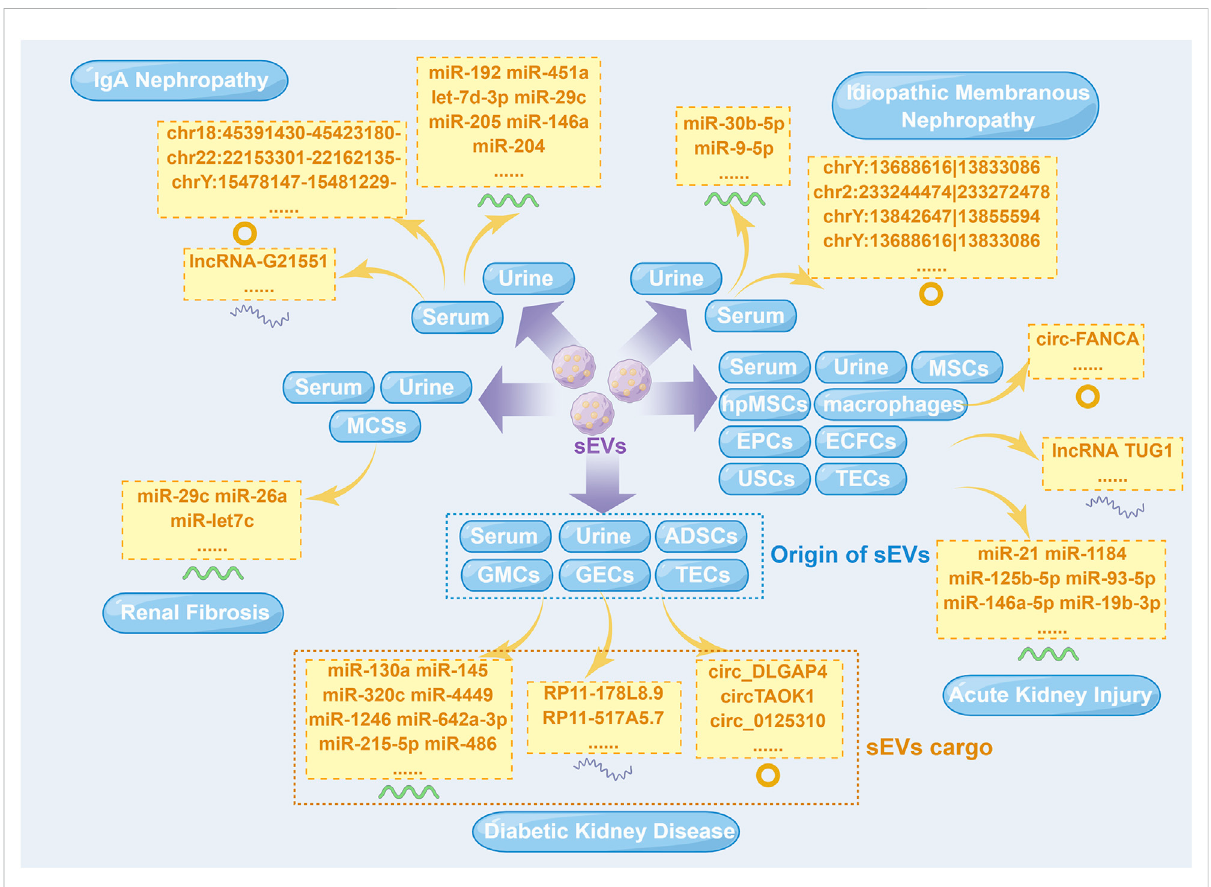
FIGURE 1 Small extracellular vesicle non-coding RNAs isolated from different cells in fi ve major kidney diseases. ADSCs, adipose-derived stem cells; ECFCs, endothelial colony-forming cells; EPCs, endothelial progenitor cells; GECs, glomerular endothelial cells; GMCs, glomerular mesangial cells; hpMSCs, human placental mesenchymal stem cells; lncRNA, long non-coding RNA; miR, microRNA; MSCs, mesenchymal stem cells; sEVs, small extracellular vesicles; TECs, tubular epithelial cells; USCs, urine-derived stem cells. This fi gure was created by Figdraw (www. fi gdraw.com) (ID: